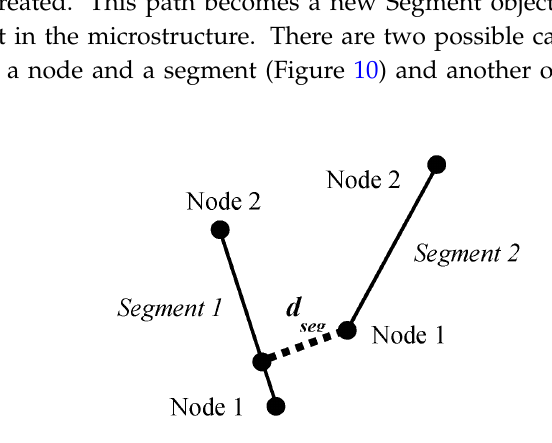
Figure 11. Tunneling path between two nodes. The distance threshold for the establishment of a tunneling path for different polymer materials was taken from Sun et al. [16], and shown in Table 1. According to Sun et al. [16], the tunneling distance is the point at which an increase in length beyond a specific threshold gives a conduction equal to zero.